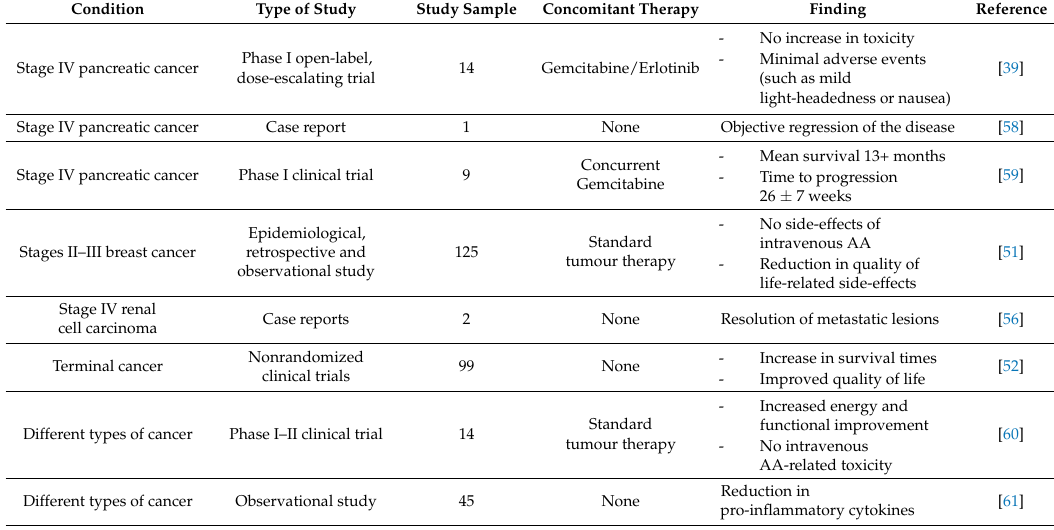
Table 1. Clinical studies of ascorbic acid (AA) in cancer in general.